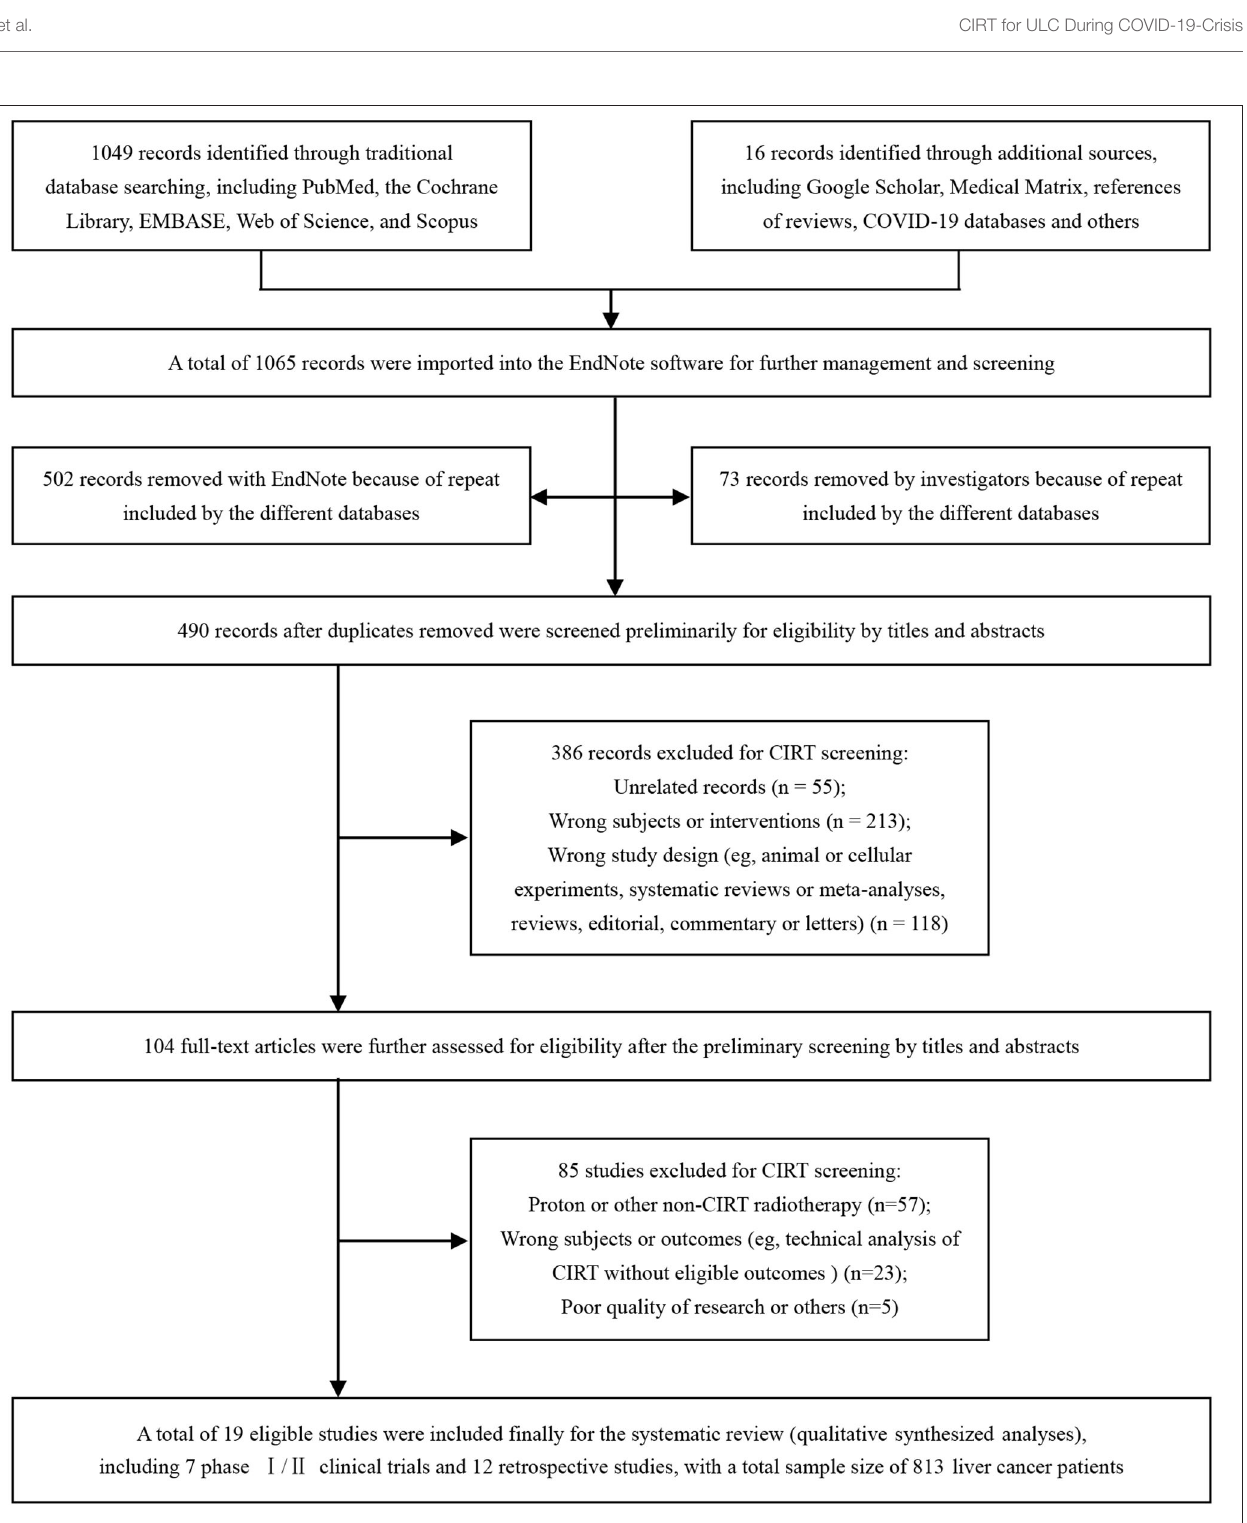
There were two studies (41, 49) regarding single fraction CIRT for metastatic liver cancer, and the results showed that single fraction CIRT was safe and effective. As a special case, a woman with a